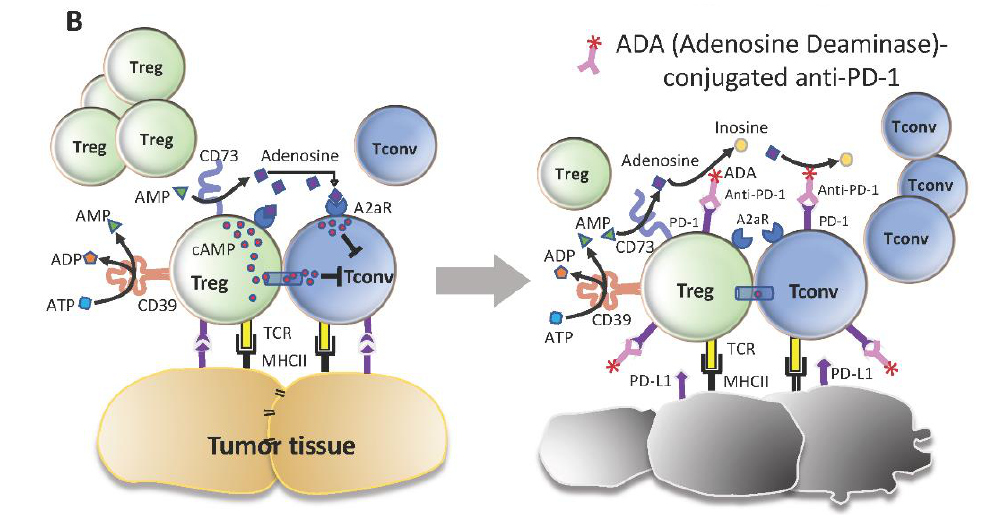
Figure 3. Possible treatment strategies for PD-1 blockade cancer immunotherapy to circumvent Tregs. ( A ) PD-1 + Tregs may first be depleted by antibodies that are bispecific for CD25 and PD-1. Subsequent treatment with PD-1 blocking antibody would likely enhance only Tconv cells and CD8 + T-cells. ( B ) The generation of adenosine by Tregs may not only suppress Tconv cells but also augment Treg activity. Hence, an obstacle to anti-PD-1 therapy. This could be addressed using anti-PD-1 antibodies conjugated with the enzyme, adenosine deaminase, which deaminates adenosine to inosine. A secondary effect could also be achieved from reduced cAMP generation in Tregs and transfer into Tconv cells.